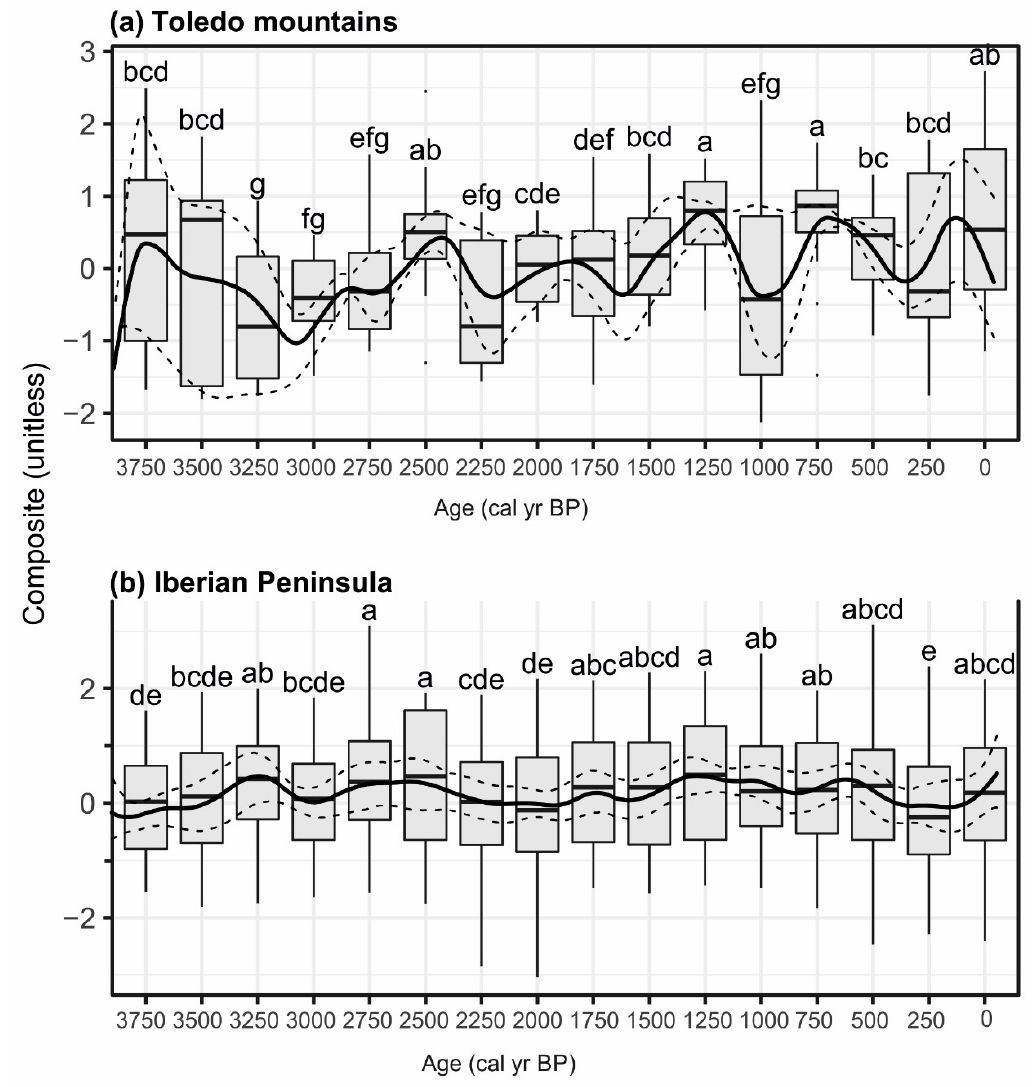
Figure 5. Composite curve of fire history in the three studied sites ( a ) and the entire Iberian Peninsula ( b ). Data obtained from the Global Charcoal Database [63], the complete list of sites used to construct the Iberian Peninsula composite curve are in supplementary Table S1. This study was combined with a Kruskal–Wallis tests to better perceive the similarities and differences between trends in both composites.